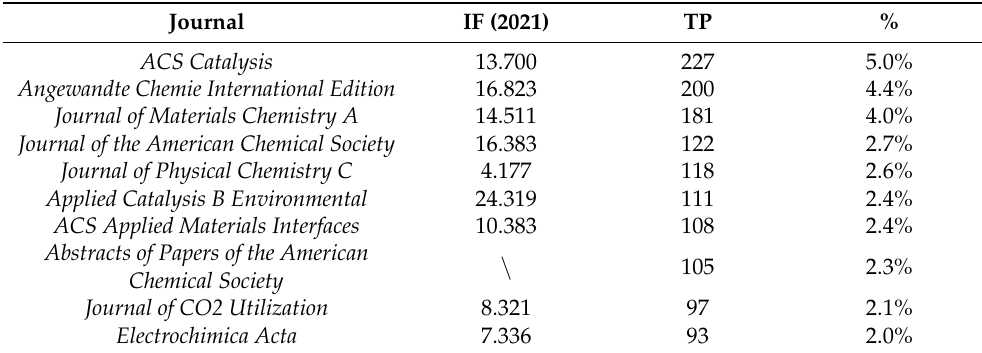
Table 2. Top ten most published journals during